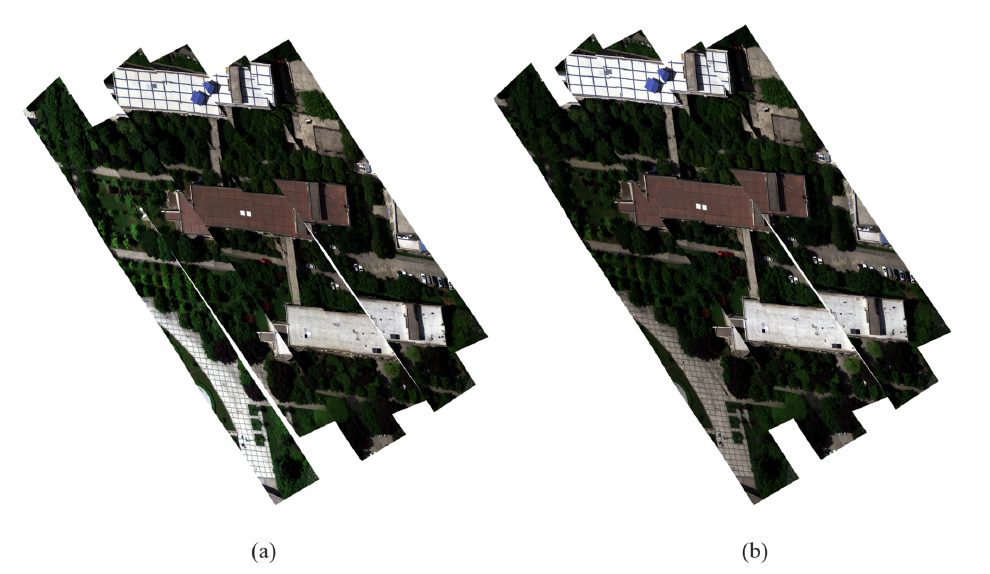
Figure 13. Results of IGM: ( a ) IGM geometric correction result; and ( b ) Mosaic result of IGM geometric correction.